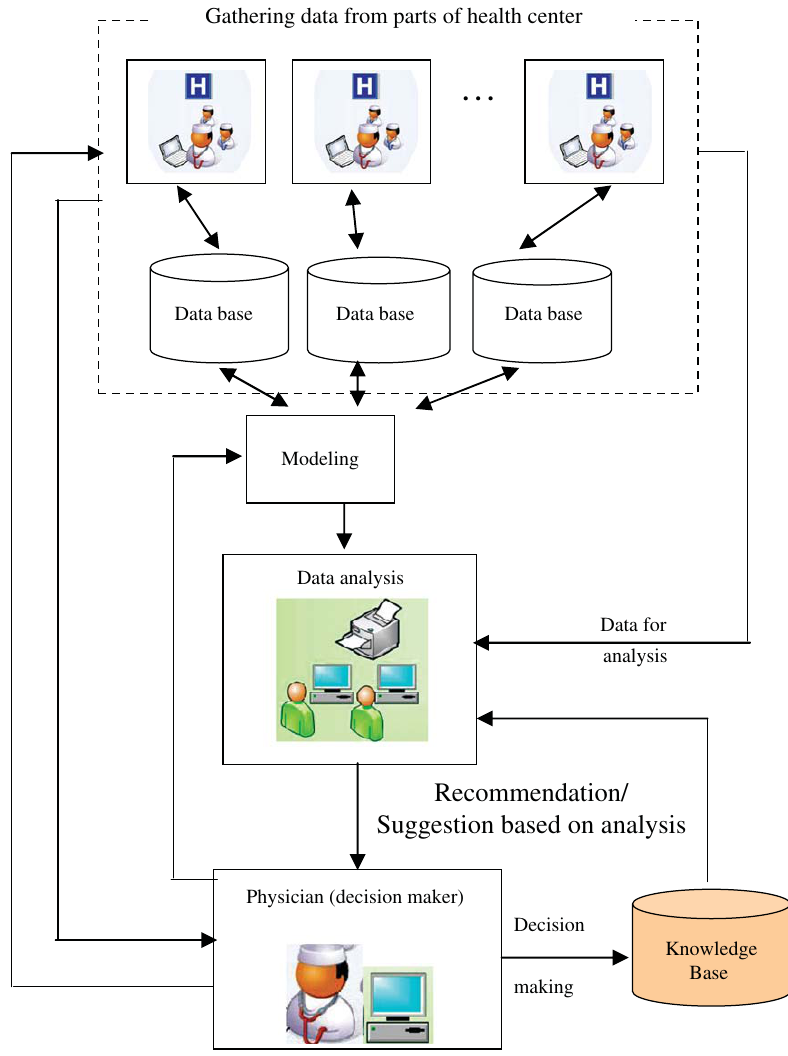
Fig. 1. A conceptual model of a Medical Decision Support